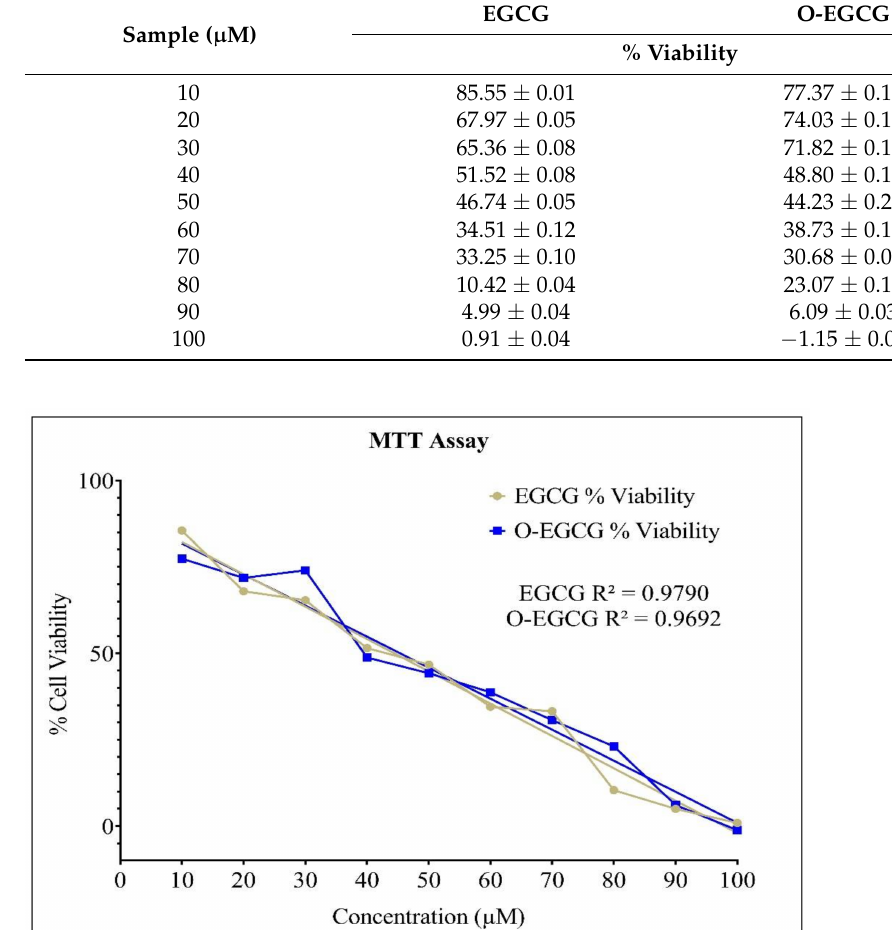
Figure 2. Cell viability of EGCG and O-EGCG on HCT-116